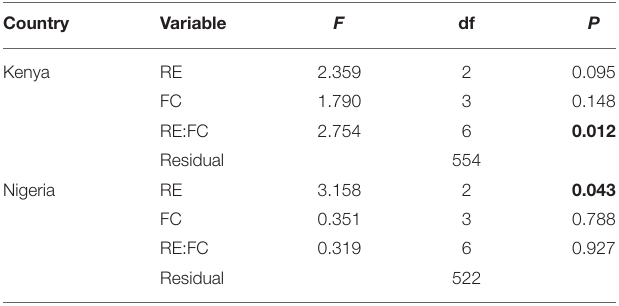
Bold type highlights significance at the 5% level.